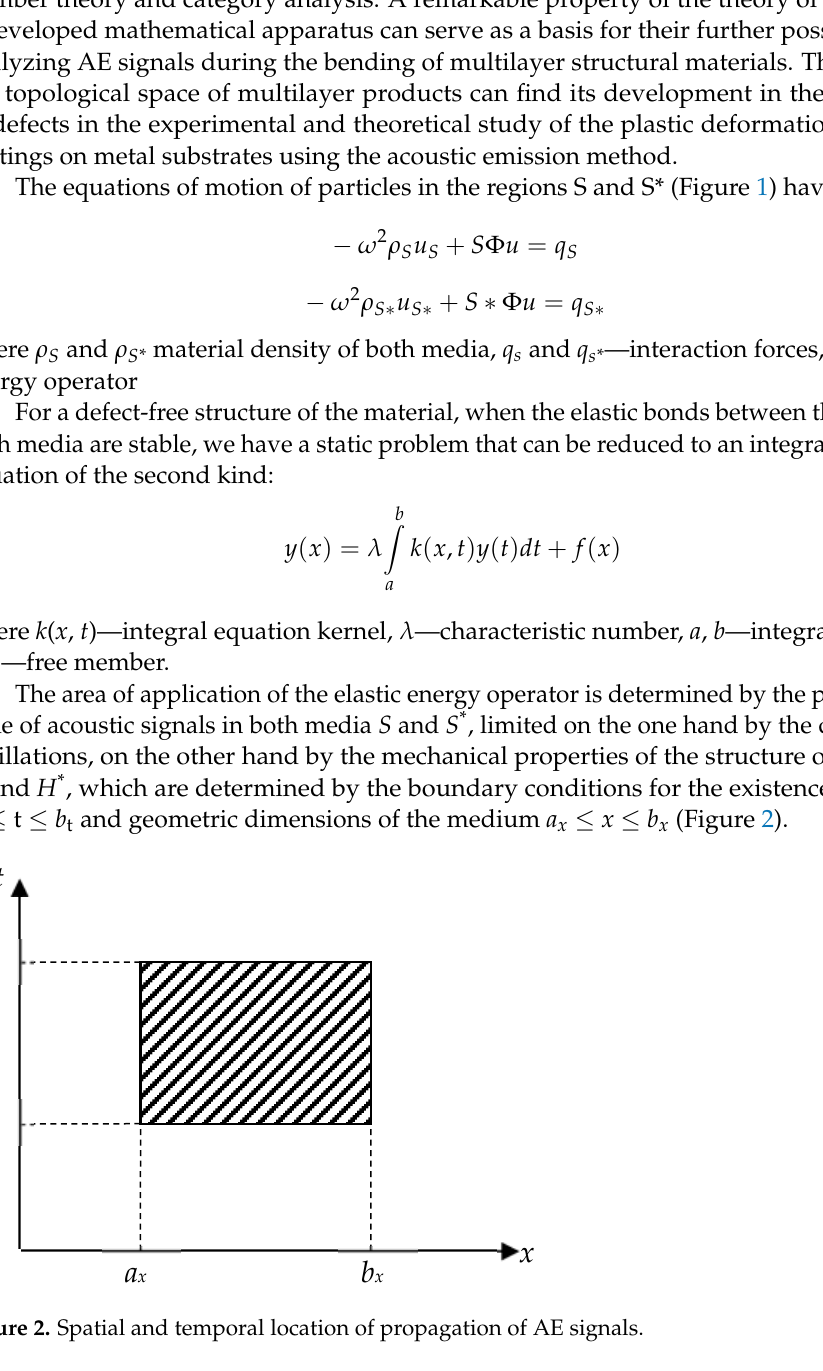
where G ( x , ω )–Green’s